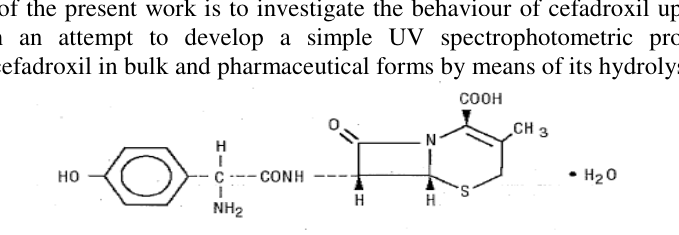
Figure 1. Structural formula of cefadroxil